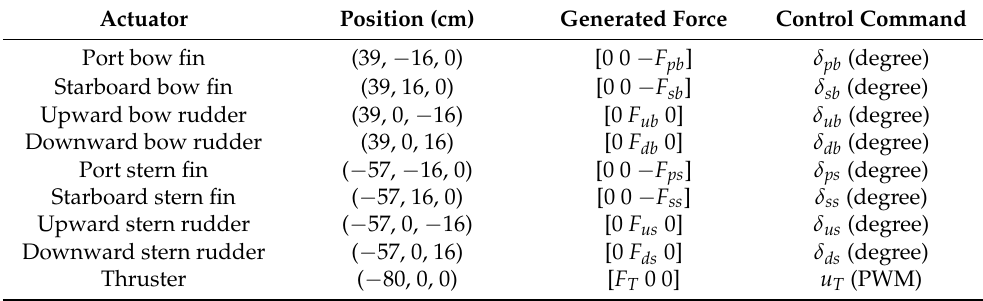
Table 3. The related specifications of fins and rudders of the developed torpedo-like underwater